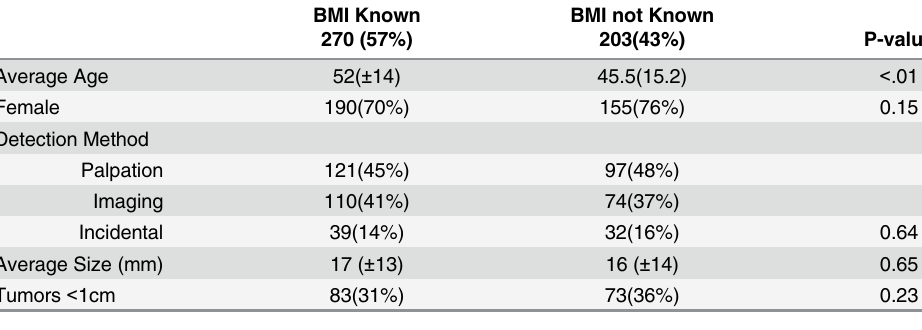
Table 1. Patient and Tumor